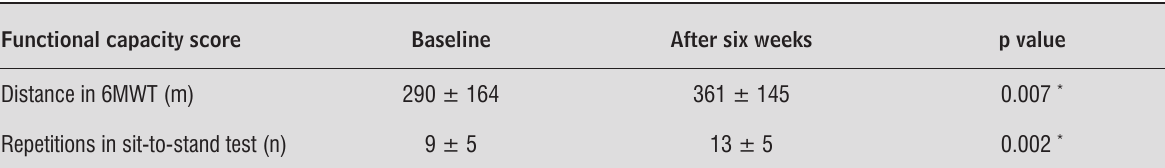
Table 1 - Functional capacity scores obtained at baseline and after six weeks of rehabilitation based on physical exer- cises in eight patients with chronic kidney disease